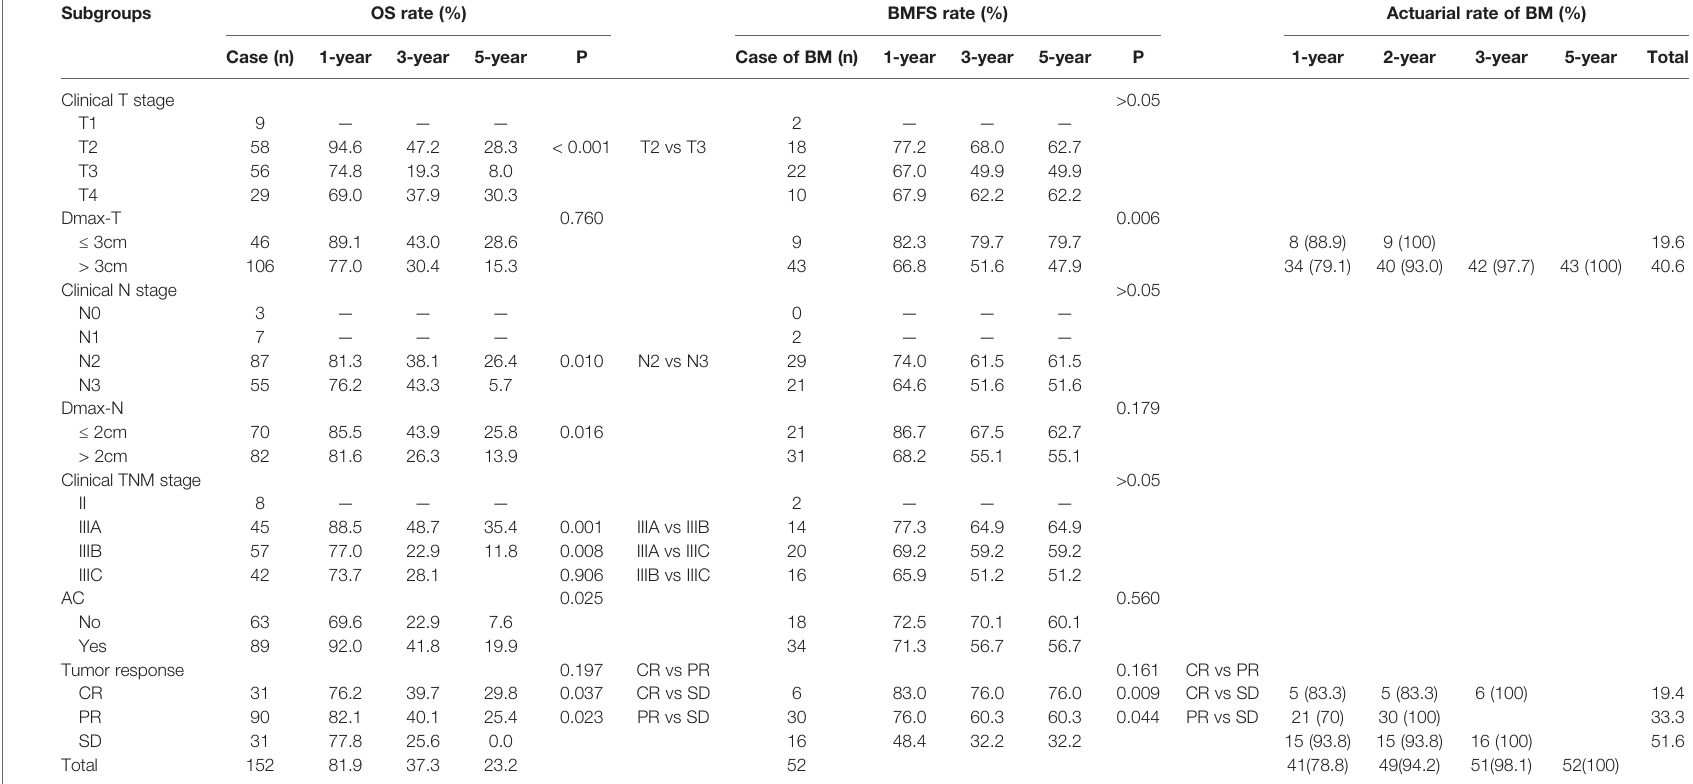
TABLE 2 | OS in the entire